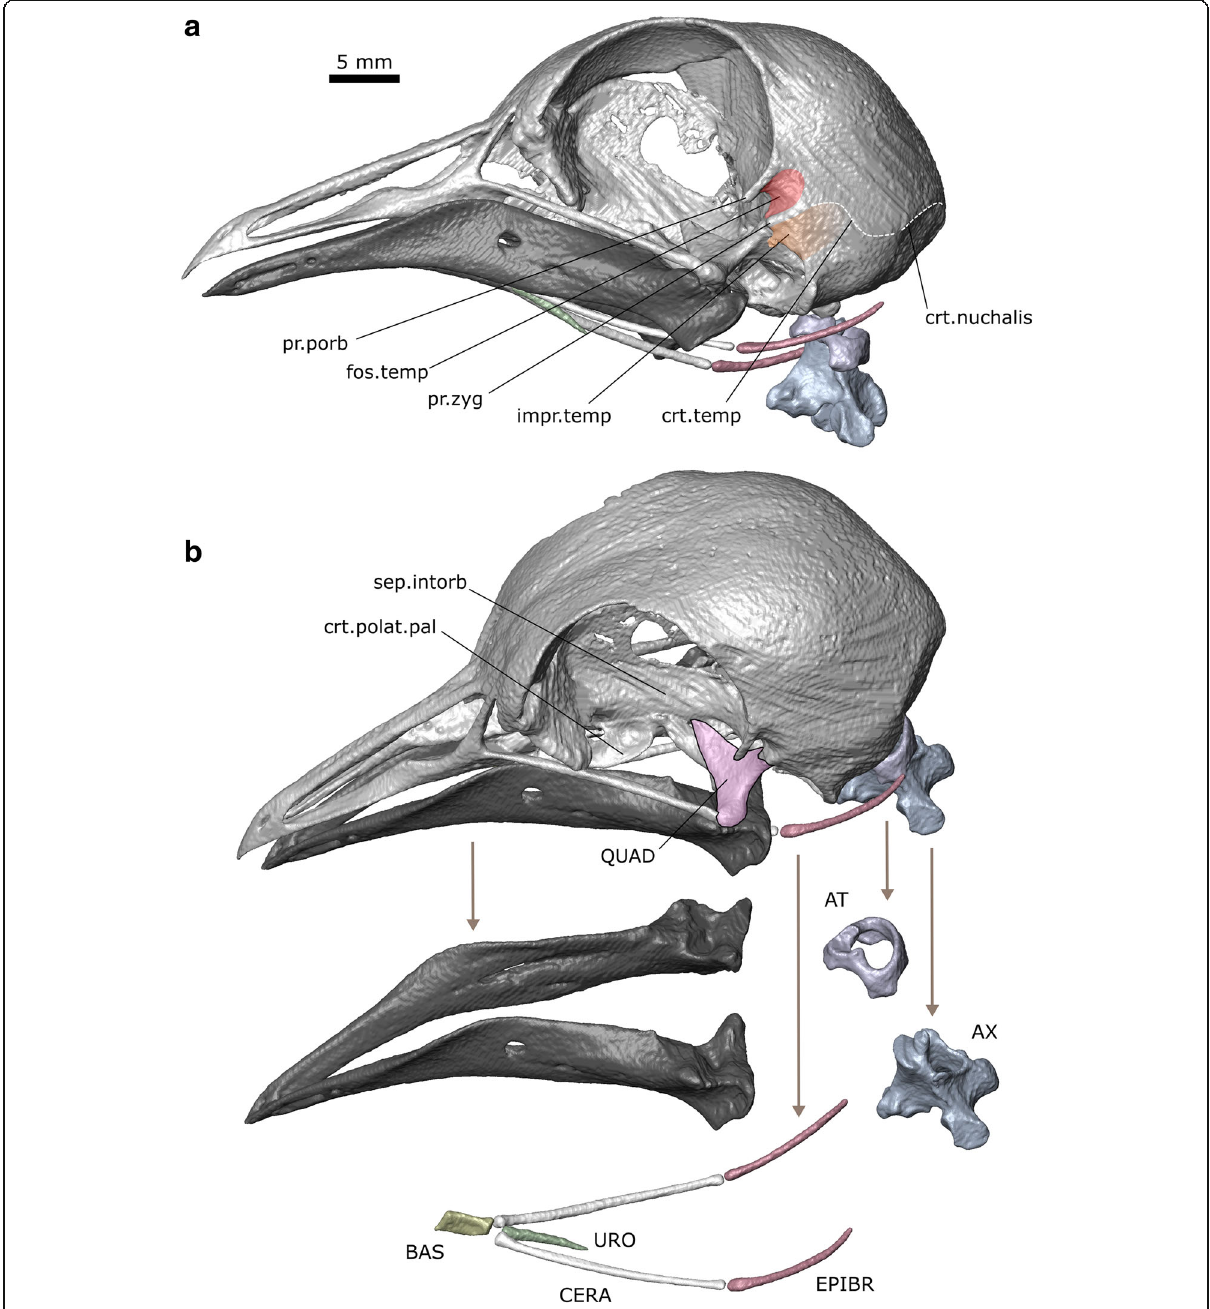
Fig. 3 Skull osteology of Columba livia . a lateral view. b dorsolateral